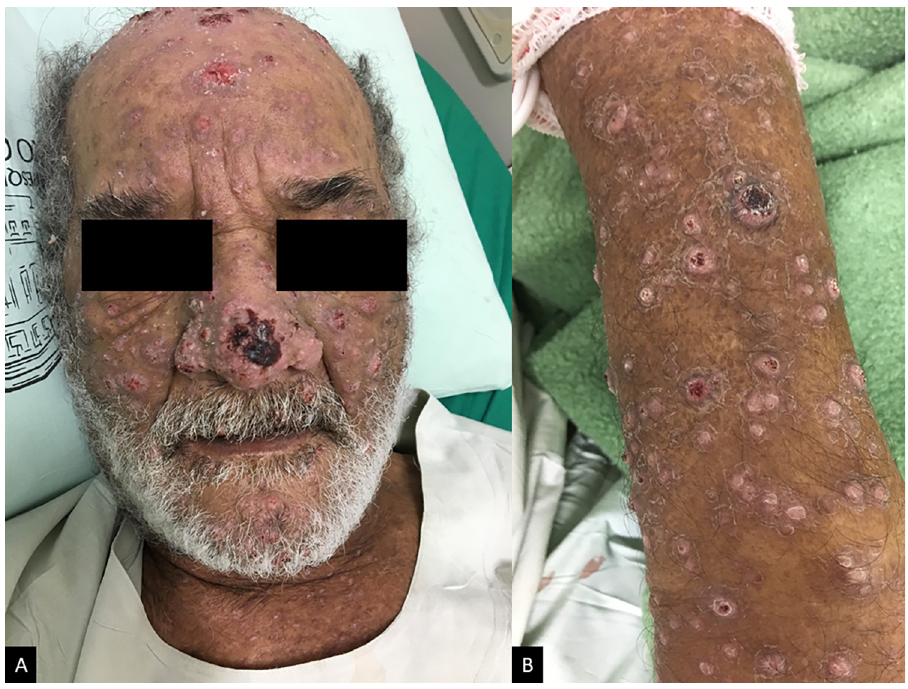
Fig 2. Cutaneous lesions due to hematogenous dissemination of Paracoccidioides sp. in a patient with HIV/aids. Patient from group B, 63 years old, presenting (A) ulcerative and ulcerous-vegetative lesions on the face, (B) papules and ulcerative lesions covered by crusts on the